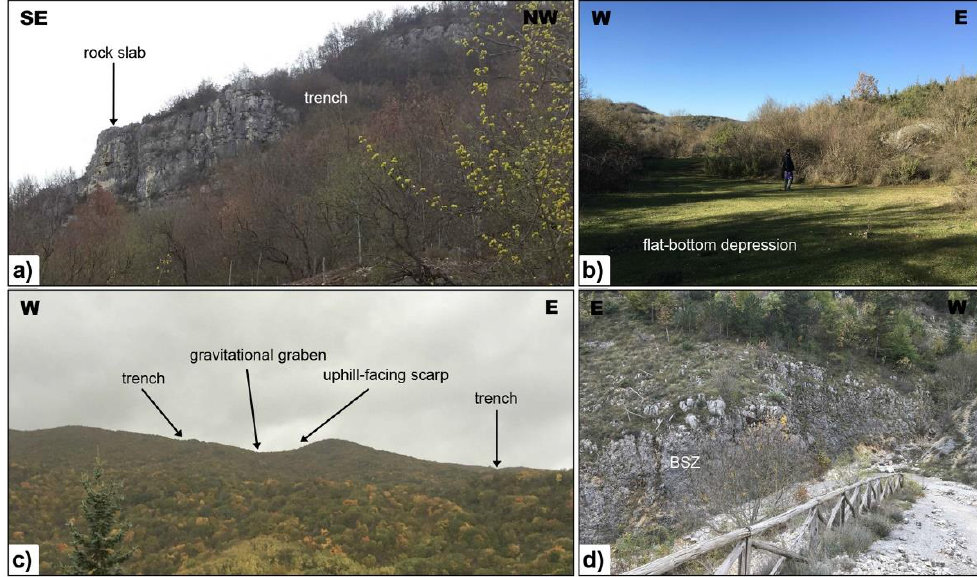
Figure 6. Morphological features of the Luco dei Marsi DSGSD: ( a ) trench; ( b ) gravitational graben with flat-bottom depression; ( c ) system of trench, gravitational graben, and uphill-facing scarp; ( d ) outcrop of the BSZ.